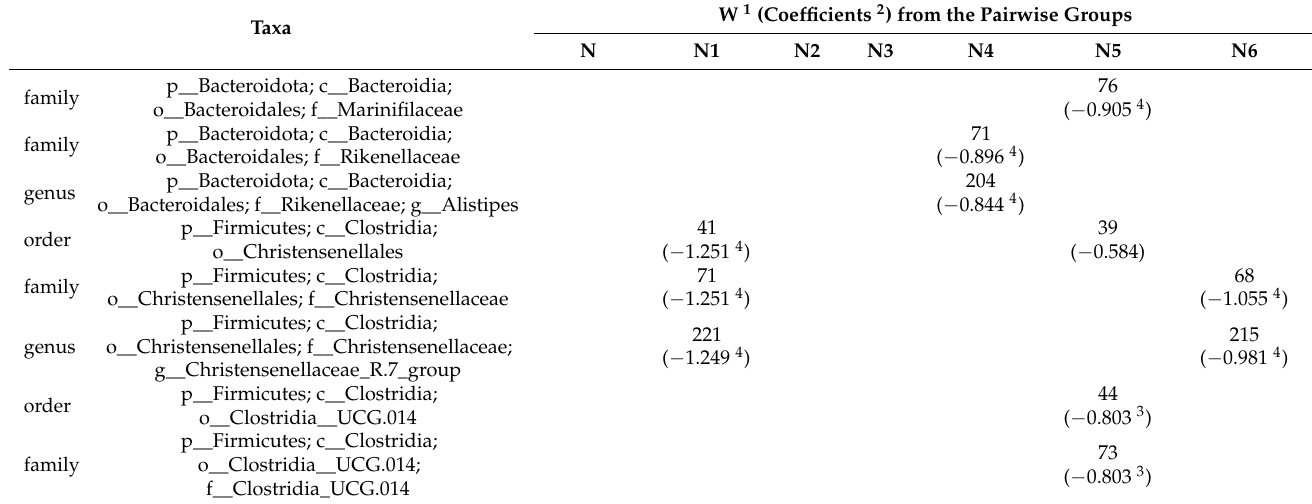
Table 2. Detection of differentially abundant taxa between the two groups for neuroticism scores and coefficients from the generalized linear model using MaAsLin on pairwise testing between the two groups.